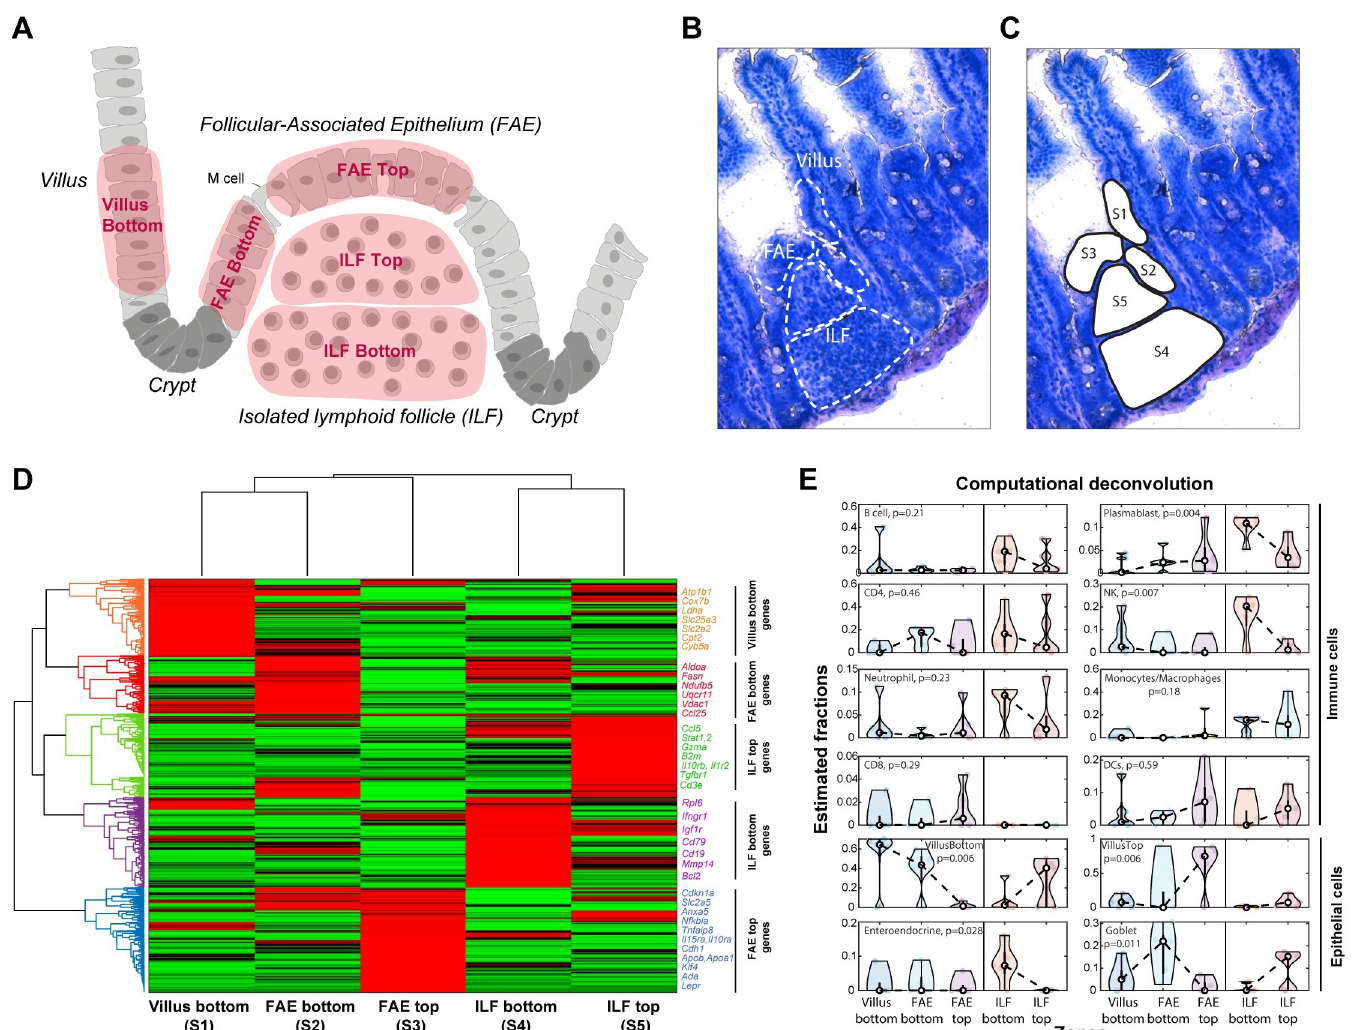
Fig 1. LCM RNA-seq of FAE and ILF. ( A ) An illustration of small intestinal region including FAE, ILF, adjacent villus, and crypts, showing the 5 dissected segments in red: VB (S1), FAEB (S2), FAET (S3), ILFB (S4), and ILFT (S5). ( B, C ) A bright field microscopy image (20 × magnification) of FAE, ILF, and the adjacent villus before and after laser dissection of the 5 segments (S1-S5). ( D ) Clustergram of LCM RNA-seq data showing gene mean expression Z-score of the 5 segments (S1-S5). Selected genes with high expression are shown on the right side of the clustergram for each cluster, colored according to the cluster color. ( E ) Estimated fractions of distinct cell types, based on computational deconvolution of the LCMseq. White dots are medians, black boxes delineate the 25–75 percentiles. The data used to generate this figure can be found in Supporting information S1 and S2 Data. P values computed using Kruskal–Wallis tests. FAE AU : AbbreviationlistshavebeencompiledforthoseusedinFigs 1 (cid:0) 4 : Pleaseverifythatallentriesarecorrect : , follicle-associated epithelium; FAEB, FAE bottom; FAET, FAE top; ILF, isolated lymphoid follicle; ILFB, ILF bottom; ILFT, ILF top; LCM RNA-seq, laser capture microdissection RNA sequencing; VB, villus bottom.